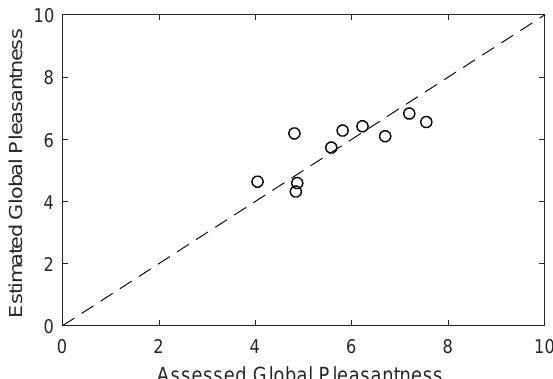
Figure 7. Estimated global pleasantness from P estimated versus assessed global pleasantness for the 10 sequences.